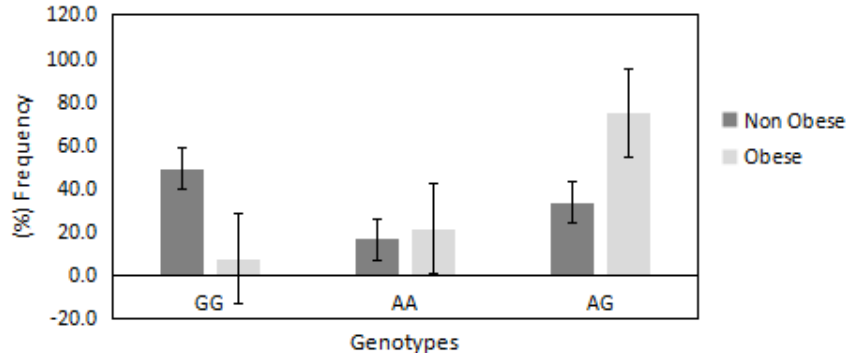
Figure 1. Distribution of PRDM16/rs2651899 genotypes in obese and non-obese groups. The frequency of the mutated genotypes AA and AG was higher in obese compared with non-obese participants (75% vs. 33% and 21% vs. 16%, respectively). In contrast, the frequency of wild-type GG genotype found to be very low in obese compared with non-obese participants (7% vs. 49%).